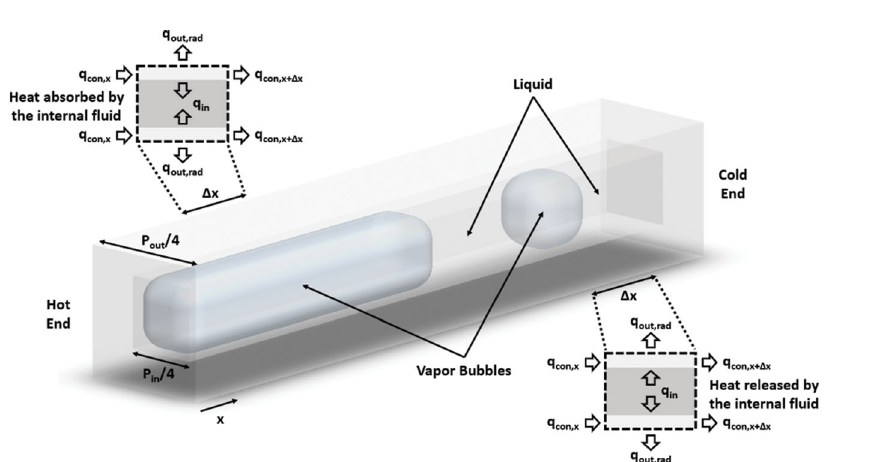
Fig. 6 One dimensional heat transfer model geometry. Schematic of the CVB heat pipe with various heat transfer mechanisms. Heat was absorbed by the internal fl uid near the hot end but was released near the cold